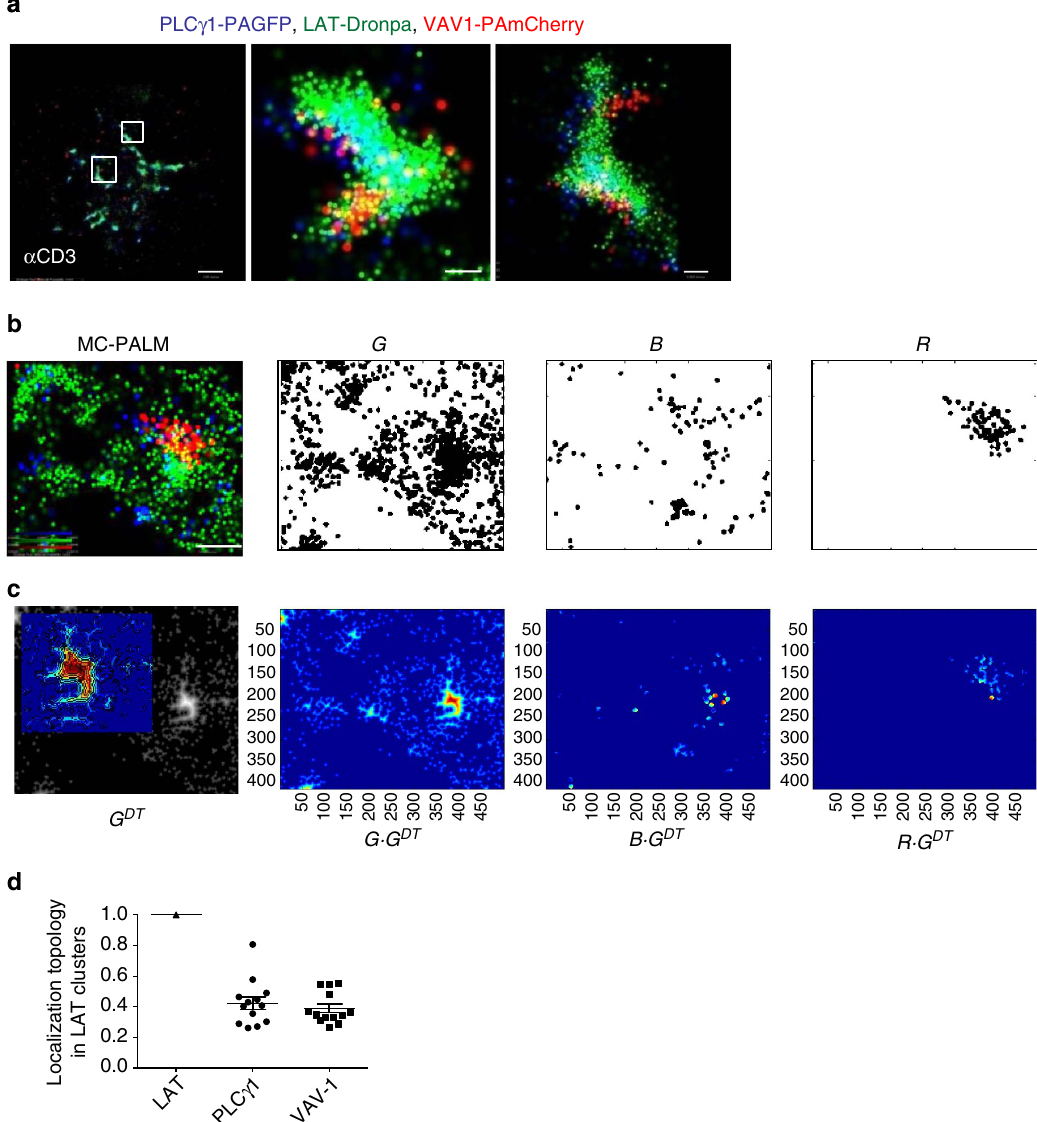
Figure 2 | An intricate structure in the recruitment of effector proteins to LAT clusters. ( a ) MC-PALM imaging of fixed Jurkat cells expressing PLC g 1-PAGFP (blue), LAT-Dronpa (green) and VAV1-PAmCherry (red), spread on an a CD3-coated coverslips for 3min before fixation. Two zoomed images of representative LATclusters are shown. Maximal probability density values for PAGFP, Dronpa and PAmCherry rendering 370, 740, 280 molecules per m m 2 , respectively. Scale bar, 2 m m (left); and 200nm (middle and right). ( b ) Sequence used to calculate localization topology (see Analyses section in Supplementary Information for further details): an MC-PALM image (left) is separated into three channels (that is, right images, labelled G,B,R ), where single molecules are represented as 20nm black disks. Maximal probability density values for PAGFP, Dronpa and PAmCherry rendering 270, 460, 140 molecules per m m 2 , respectively (colour bars in the left panel represent probability densities). Scale bar, 0.5 m m. Note that these imprints are shown as aids to the reader and did not affect any of the analyses. ( c ) A distance transform is performed for the green LATchannel, generating an image G DT (left), where the intensity increases with distance from the cluster boundary. An inset in the G DT image shows a magnified view of a LATcluster in G DT using heat map colour coding. The binary images from all three channels are multiplied by G DT to produce weighted images of the binary images G , B and R (right images; images rendered using heat map colour coding). ( d ) Relative localization topologies (the average intensity of a weighted binary image divided by the average intensity of the LAT-weighted binary image) for the three channels of multiple cells ( n ¼ 13) expressing LAT-Dronpa, PLC g 1-PAGFP and VAV1-PAmCherry rendered using heat map colour coding (see Supplementary Information for further than those recruited to the periphery of clusters. Note that centres of LAT clusters (Fig. 2d). The localization topology is localization topology of over 1 is possible in cases where a specific computed by dividing the average intensity from each weighted molecular species is enriched at the centre of clusters, with respect binary image (Fig. 2c, three right images) by the average intensity to the molecular species that defines the cluster; however, we did from the LAT-weighted image (Fig. 2c, image labelled G (cid:2) G DT ). Thus the localization topology of LAT is set to 1 and typical not observe such a case in our experiments. Similar localization values for other molecules range from 0 to 1. Molecules that tend topologies were found for PLC g 1 and VAV1 in individual and to be recruited to the centres of LAT clusters have higher values multiple cells (Fig. 2d), indicating that the two molecules were